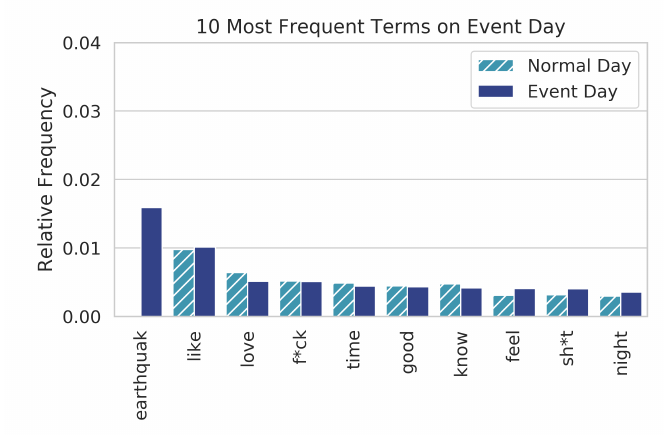
Figure 2. Relative frequency of the ten most frequent terms in the earthquake dataset on the day of the event compared to their relative frequency in the comparison dataset of a normal